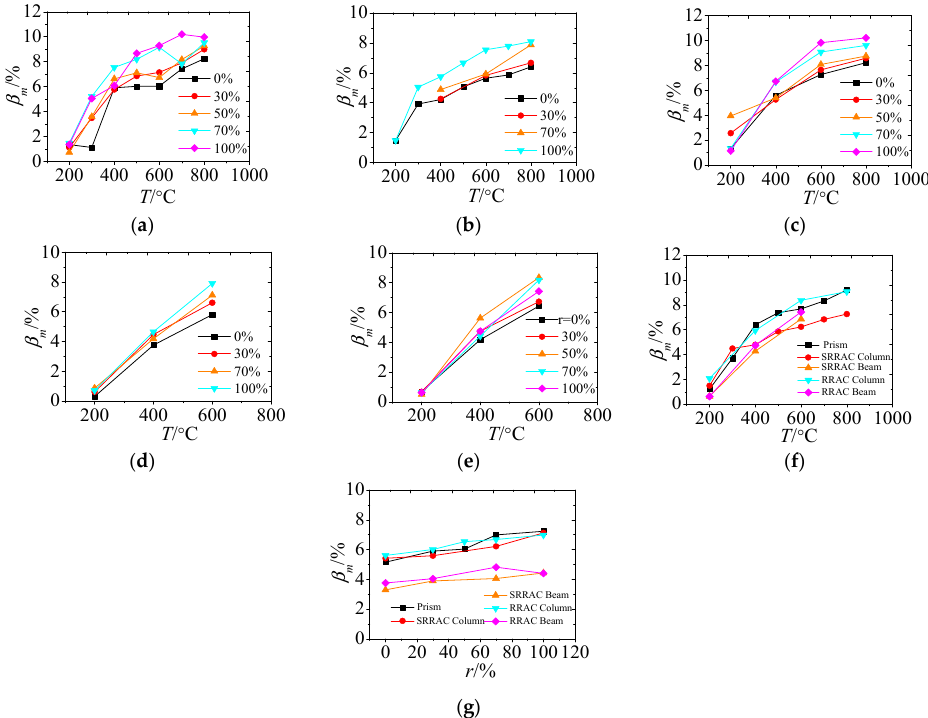
Figure 7. The mass loss. ( a ) Prism; ( b ) SRRAC column; ( c ) RRAC column; ( d ) SRRAC beam; ( e ) RRAC beam; ( f ) Influence of temperature; ( g ) Influence of replacement percentage.